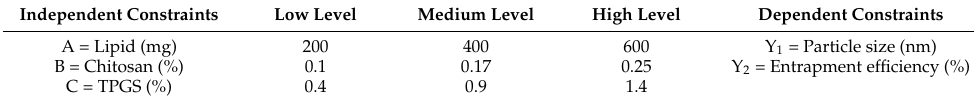
Table 1. Independent variables used to optimize Naringin hybrid nanoparticles (NG-HNs).